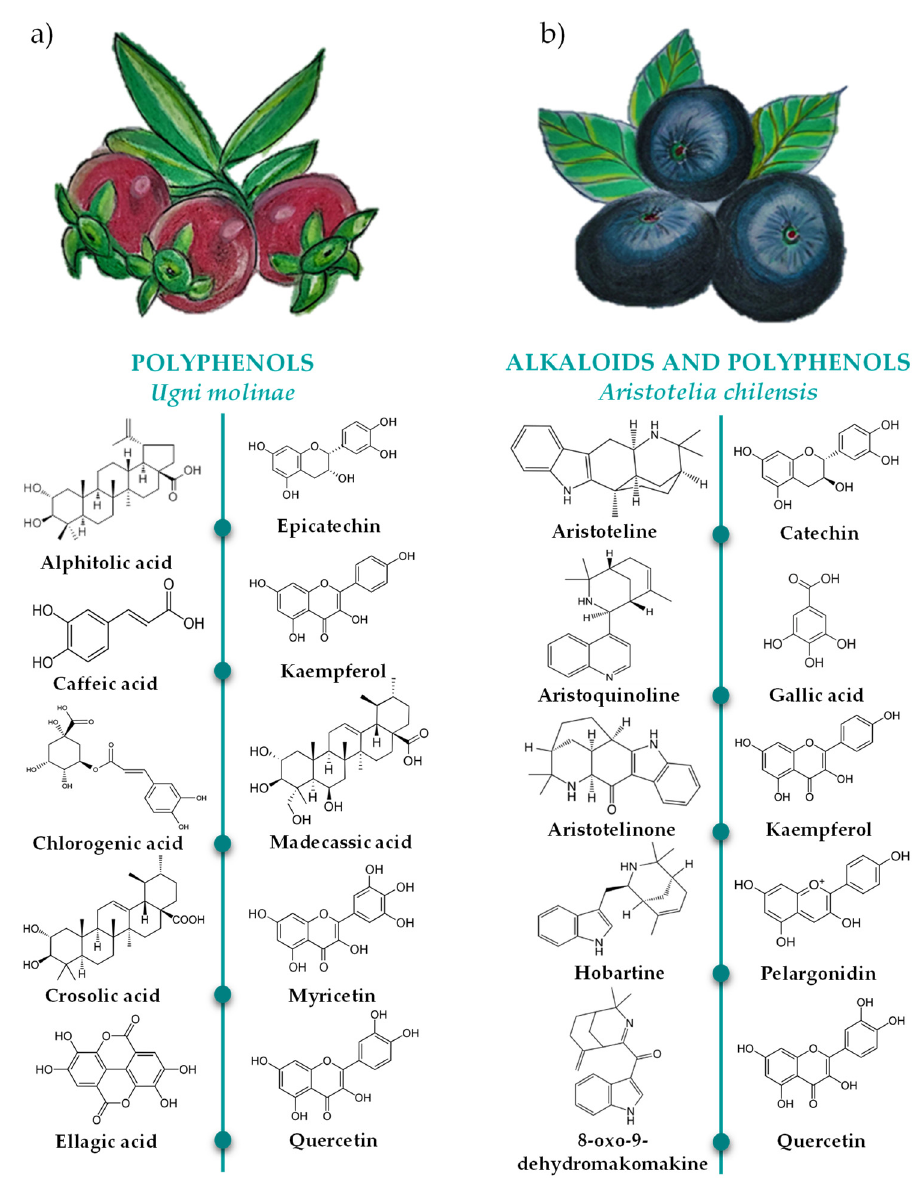
Figure 2. Main bioactive compounds present in the leaves of Ugni molinae Turcz ( a ) and Aristotelia chilensis ( b ) [73–76]. from naringenin (flavone) in the presence of the enzyme flavone 3-hydroxylase [77].